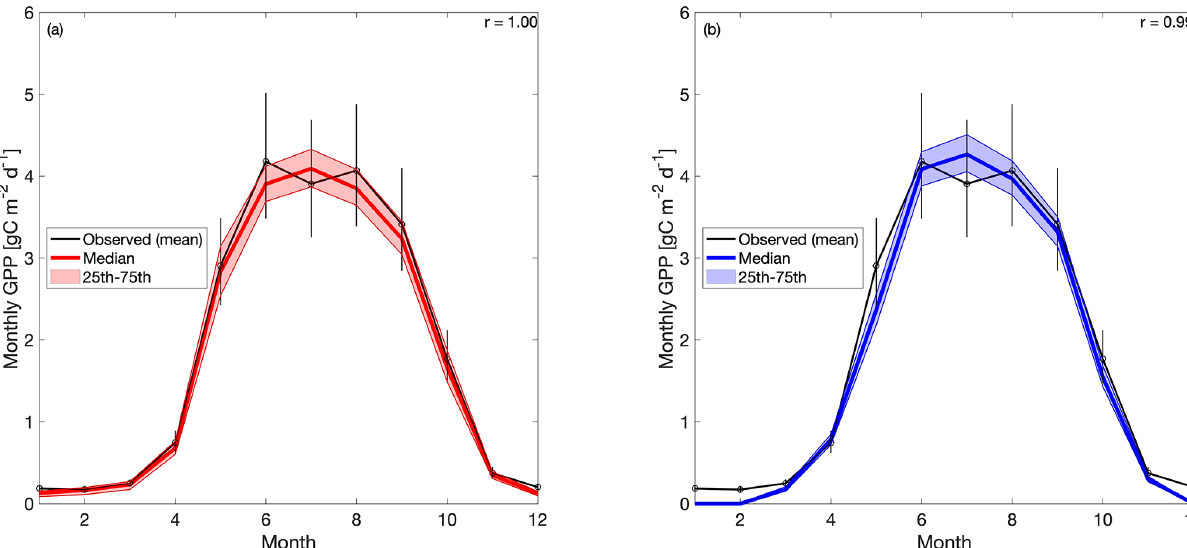
Figure 4. Tower-derived average monthly GPP (black line) and modeled GPP seasonal cycles at US-NR1 for 2000–2018, for (a) CARD and (b) CARDcold experiments. The half-assimilation experiments (CARD-Half and CARDcold-Half) can be found in the Supplement (Fig. S5). Model outputs include the median value of each experiment (bold colored line) with the 25th–75th percentiles of the ensembles (shaded area). The median is plotted instead of the mean to avoid impact of outlier ensemble members ( N = 4000). Error bars are tower- (cid:112) ( log ( 2 ) 2 · n)/n) . n is number of years on average ( n = 19). r is Pearson’s derived GPP multiplied and/or divided by exp (